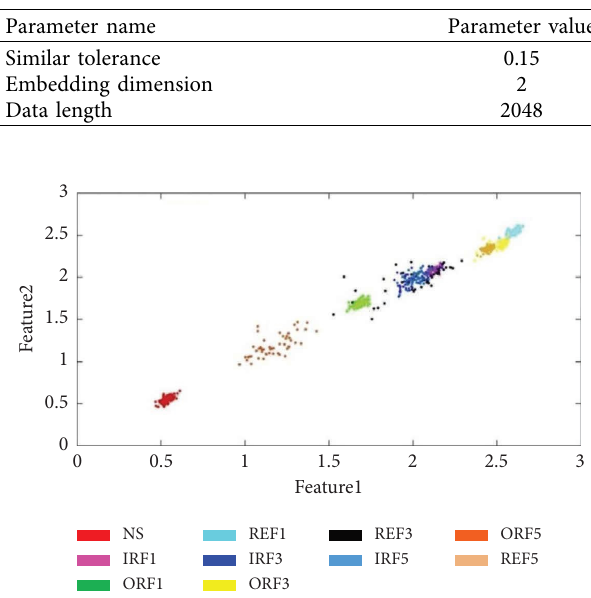
Figure 9: Computation result of absolute skewness of IMFE. Table 2: Te parameter settings of IMFE